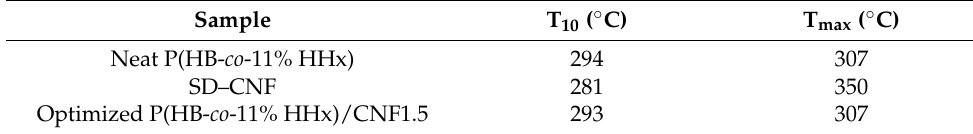
Figure 5. TG and DTG curves for neat P(HB- co -11% HHx) and P(HB- co -11% HHx)/CNF1.5 bionanocomposites (Red arrow shows the zoom in peak for SD-CNF for DTG). Table 7. Thermal degradation temperatures of neat P(HB- co -11% HHx) and P(HB- co -11% HHx)/CNF at 10 wt.% of weight loss (T 10 ) and maximum degradation temperature (T max ).